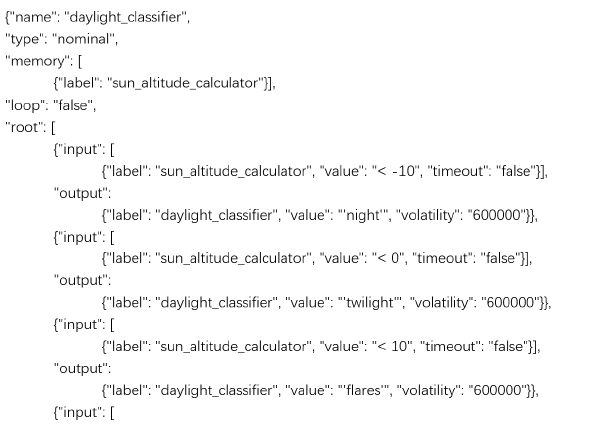
Figure 8. ( a ) The JSON configuration for the total acceleration magnitude calculator node that uses feedforward numerical processing. ( b ) The pseudocode of the server components that compiles the numerical-processing JSON file delivering JavaScript code.